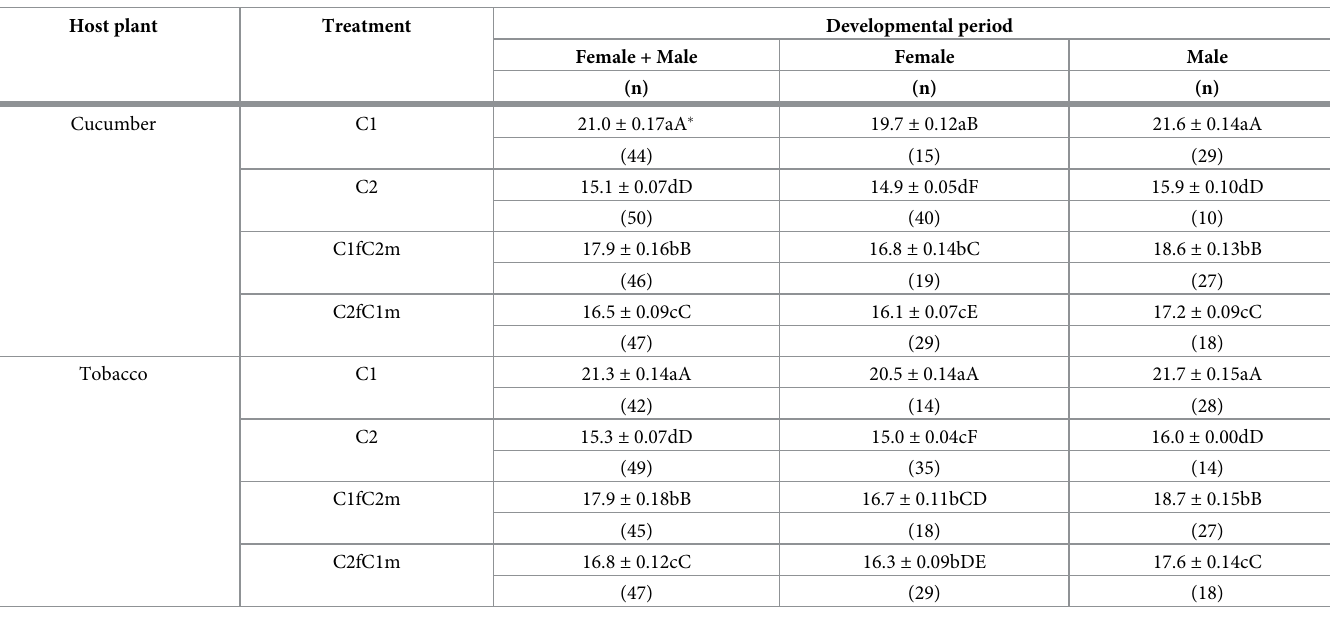
Table 5. Developmental period (mean ± S.E.) of B . tabaci